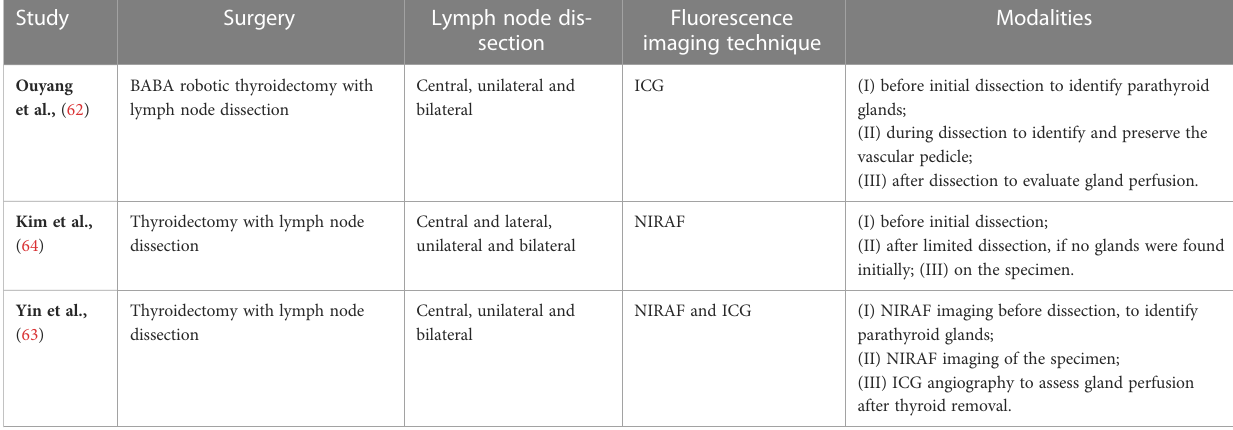
TABLE 2 Type of surgery, lymph node dissection, and fl uorescence imaging modality used in the reviewed studies. Study